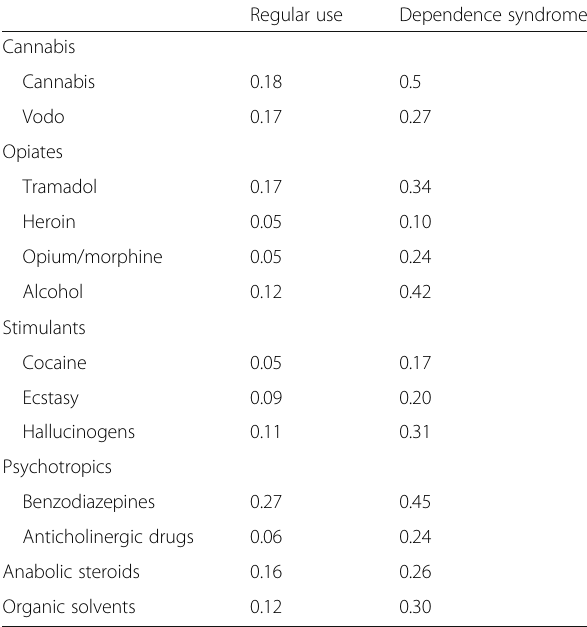
Table 3 DSM-IV dependence syndrome and regular use of substances self-reported by the students Regular use Dependence